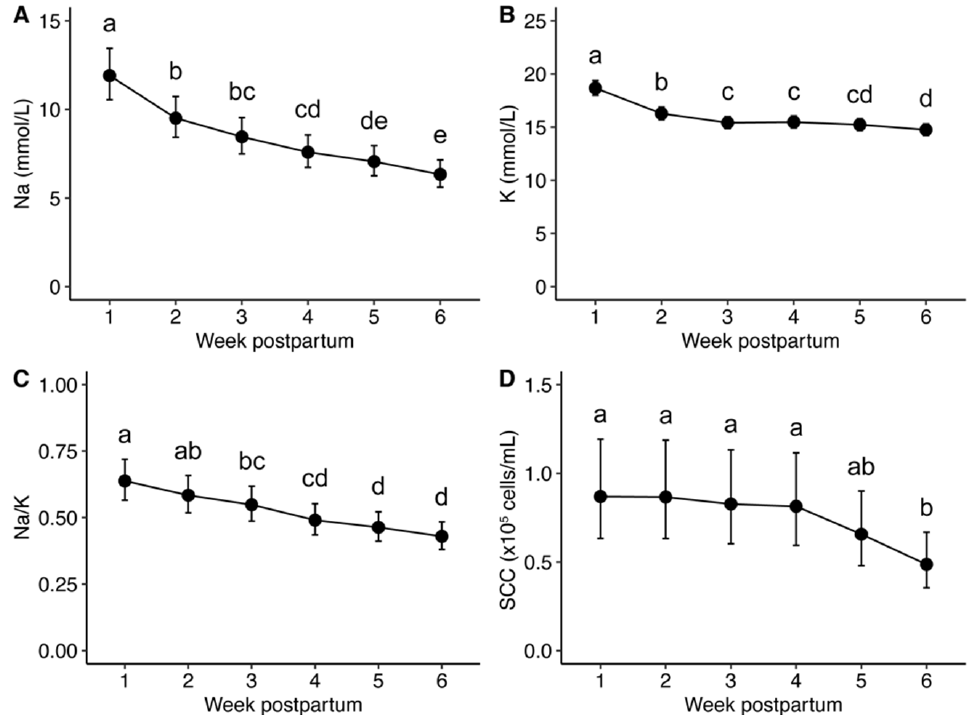
Figure 2. Measurements of ( A ) Na concentration, ( B ) K concentration, ( C ) Na/K ratio, and ( D ) somatic cell count (SCC) in milk produced by healthy participants during the first 6 weeks postpartum. Data are model-based estimates, means ± 95% confidence intervals. Letters denote significance groups over time, Tukey’s method p < 0.05.